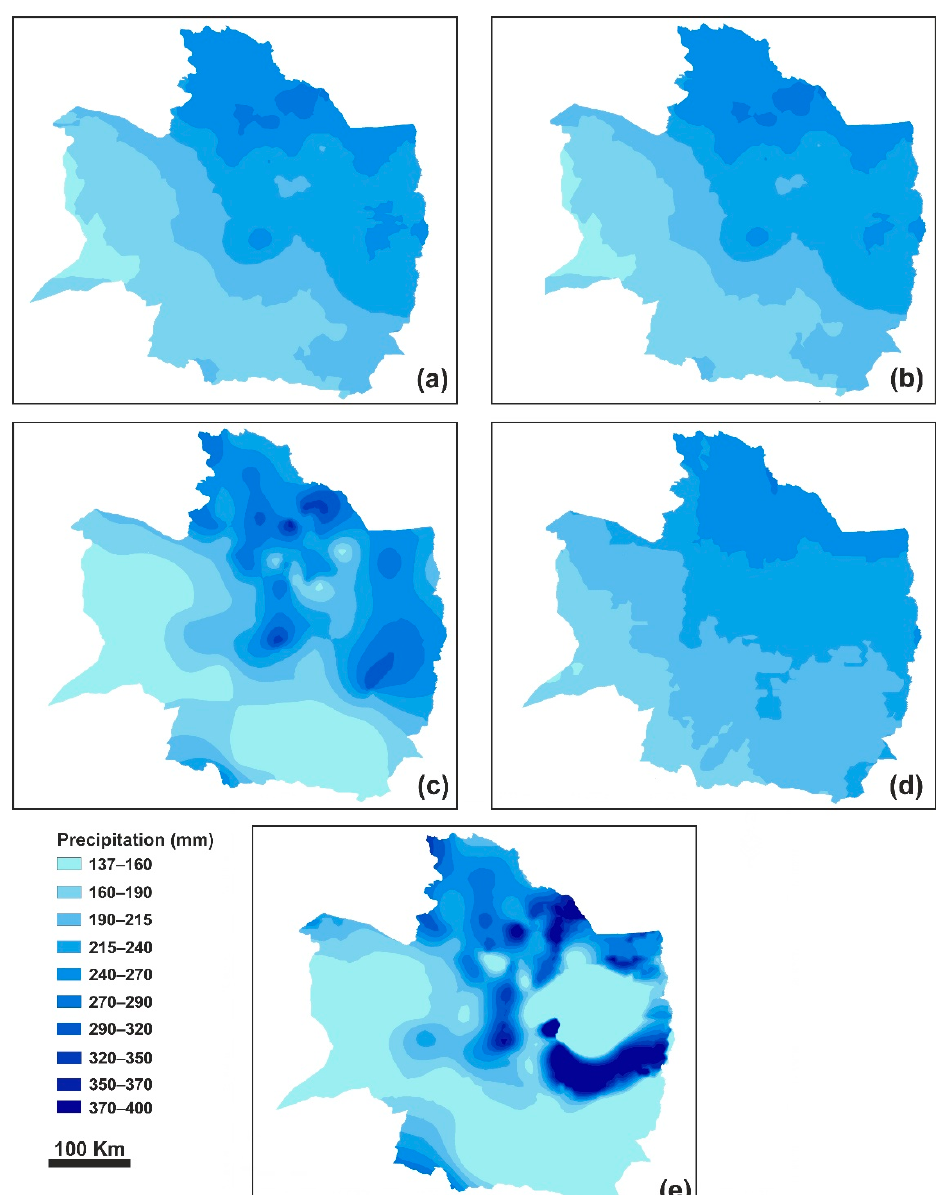
Figure 3 . Interpolated annual precipitation maps based on the five Radial Basis Functions: ( a ) Completely Regularized Spline, ( b ) Spline with Tension, ( c ) Multiquadric, ( d ) Inverse Multiquadric, ( e ) Thin-Plate Spline.